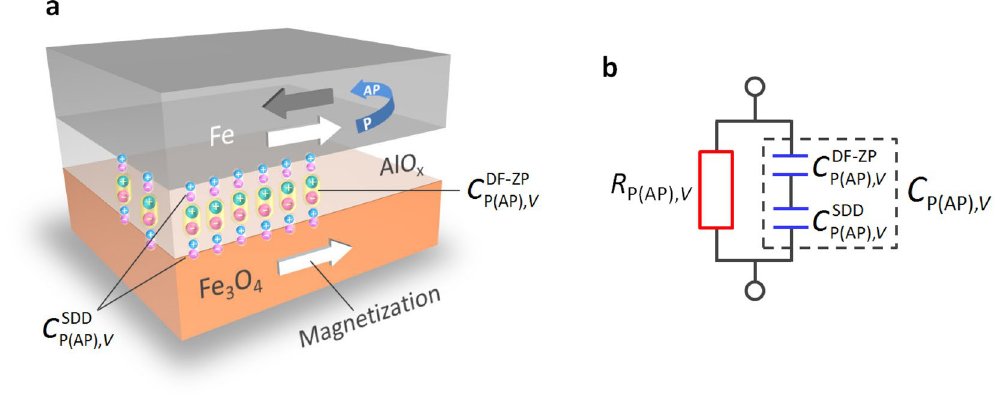
Figure 2. Modeling of the inverse TMC. ( a ) Schematic image of charge accumulation, contributing to − C f ( ) − C f ( ) P(AP),SDD , in Fe/AlO P(AP),DF ZP and C P(AP),DF ZP is described by the Debye-Fröhlich model combined x /Fe 3 O 4 . V V V with Zhang formula and parabolic barrier approximation, for the P(AP) state under the dc applied voltage V [equation (1)].